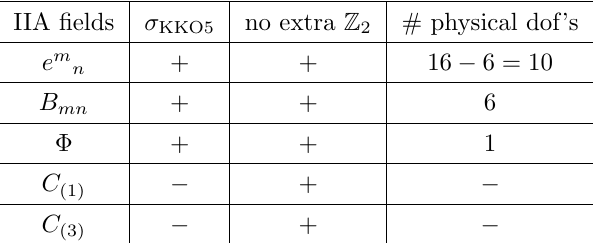
Table 10 . Counting of the total 17 propagating scalar dof’s allowed by KKO5-planes in type IIA compacti(cid:12)cations down to six dimensions. This is exactly the dimension of the supergravity coset given in (3.1), once we subtract from e m n the 6 unphysical directions corresponding to SO(4)